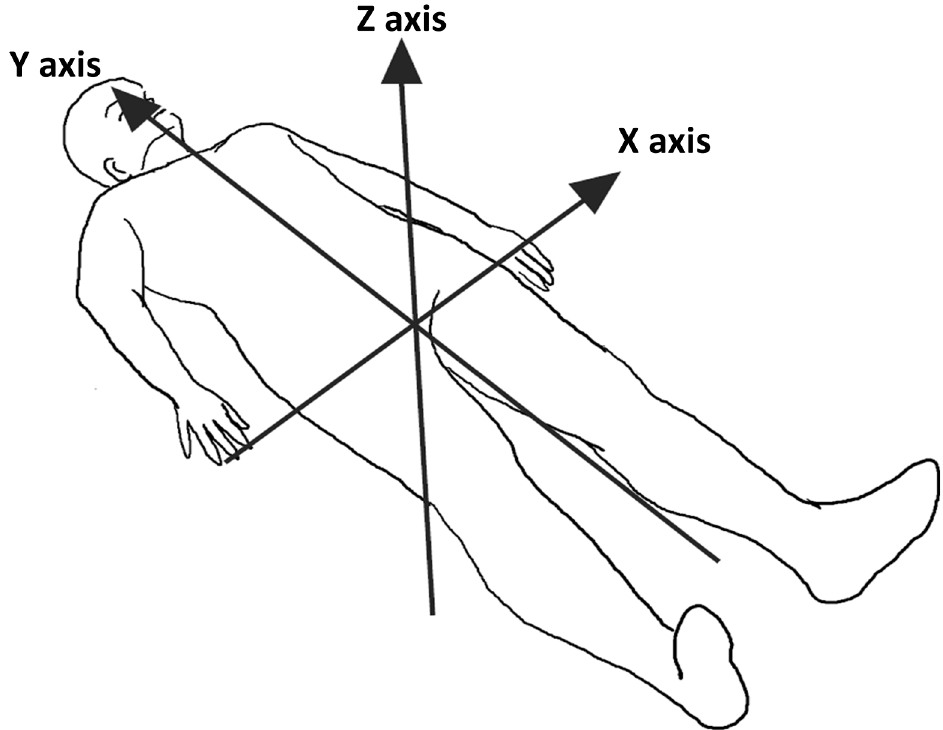
Fig 1. Three-axis accelerometer sensor axes in the recumbent position. X axis: from right to left; Y axis: from caudal to rostral; Z axis: from back to front.